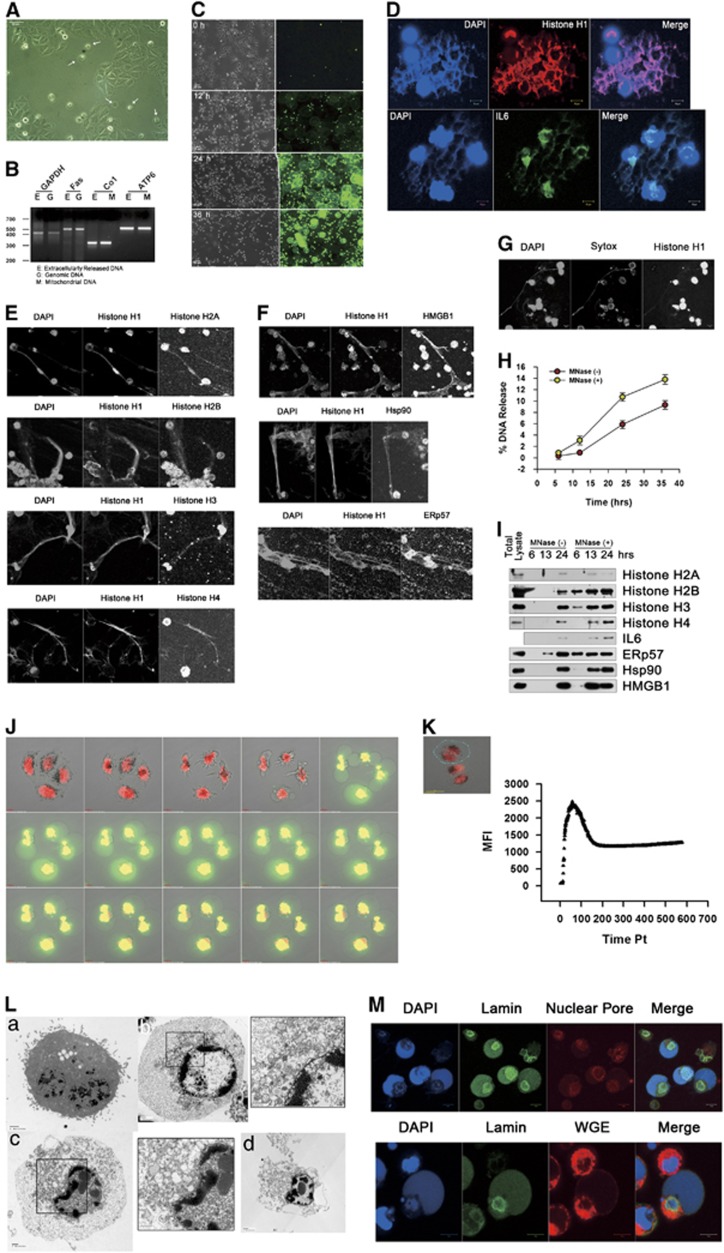
Release of nucleosomes and DAMPs from amino-acid-depleted HeLa cells. (A) An inverted microscopic image of HeLa cells in the condition of amino-acid depletion. Arrows designate dying HeLa cells. (B) Genomic sequences of glyceraldehyde-3-phosphate dehydrogenase (GAPDH), Fas, cytochrome oxidase subunit 1 (Co1) and ATP synthase subunit 6 (ATP6) were PCR amplified from extracellularly released DNA, genomic or mitochondrial DNAs. (C) Inverted and fluorescent microscopic images were taken from amino-acid-deprived HeLa cells in the presence of SYTOX, a membrane-impermeable DNA dye. HeLa cells deprived of amino acids for 15 h were fluorescence stained with histone H1 or IL6 antibodies (D), histone H2A, H2B, H3 or H4 antibodies (E) or HMGB1, Hsp90 or ERp57 antibodies (F) in combination with histone H1 antibody and 4',6-diamidino-2-phenylindole (DAPI). (G) Amino-acid-deprived HeLa cells were stained with SYTOX to determine viability, fixed and stained with DAPI and histone H1 antibodies. (H) Amino-acid-deprived HeLa cells were untreated or treated with MNase (500 mU/ml) for 10 min. Released DNA was quantitated at the indicated times. Data from triplicate samples are presented as mean±S.D. (I) Conditioned media from amino-acid-deprived HeLa cells treated or untreated with MNase were western blotted with histone H1, 2B, H3, H4, IL6, ERp57, HMGB1 or Hsp90 antibodies. (J) Images captured every hour from live imaging of amino-acid-deprived HeLa cells with SYTOX (green) and DRAQ5, membrane-permeable DNA dye (red). (K) SYTOX fluorescent intensities were measured from circularized areas of live imaging of amino-acid-deprived cells in 5-min intervals. (L) TEM images of control cells (La) and amino-acid-deprived HeLa cells (Lb–Ld). (M) Amino-acid-deprived HeLa cells were fluorescence stained with lamin and nuclear pore antibodies, or lamin antibody and wheat germ agglutinin (WGE)